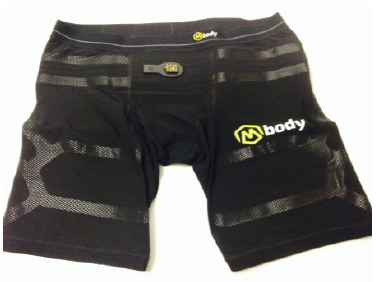
Figure 1. Electromyography (EMG). MBody shorts on the outside.